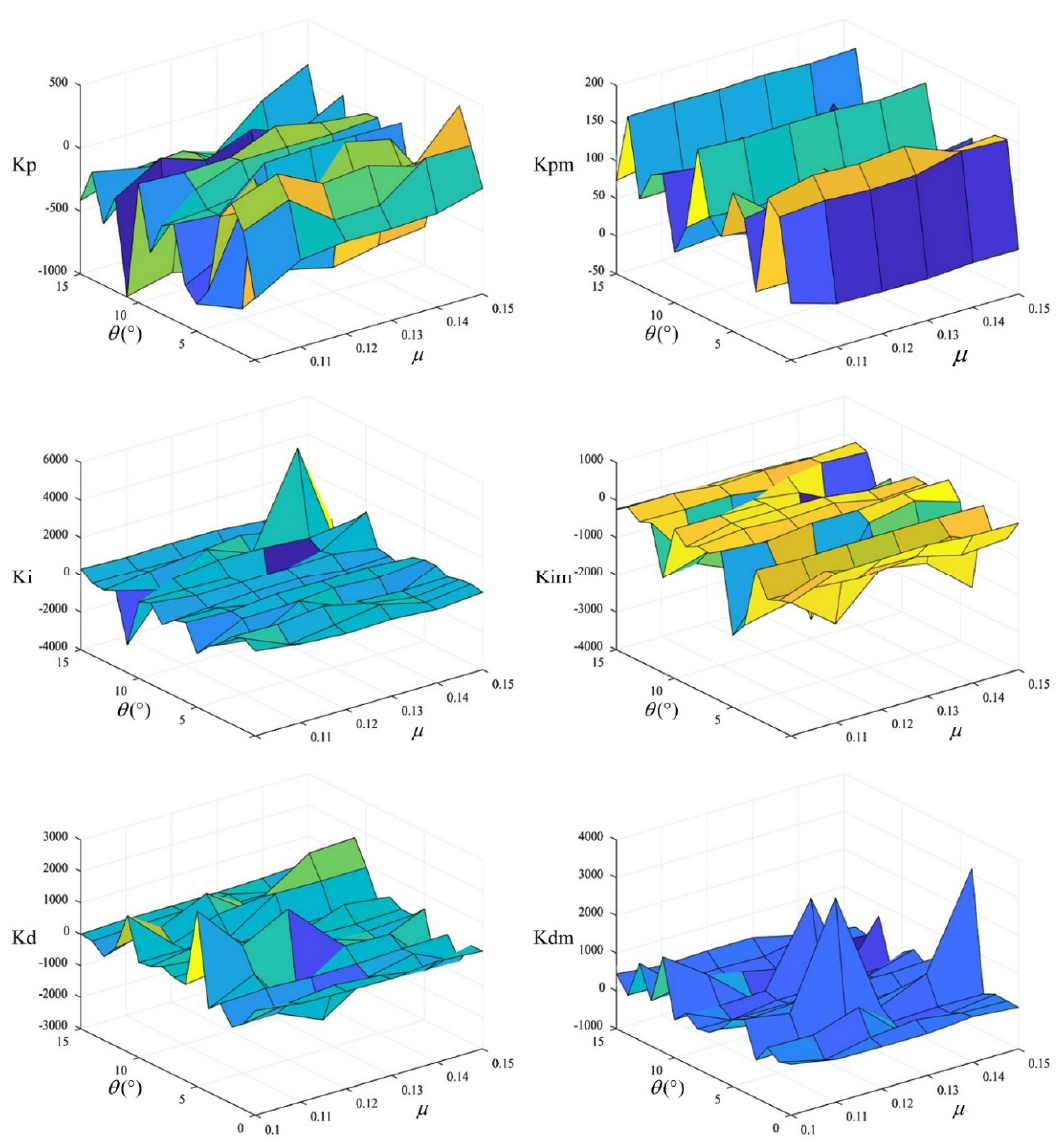
Figure 9. Example of the maps of the proportional-integral-differential (PID) controllers’ parameters during the upshift process from 1st gear to 2nd gear.